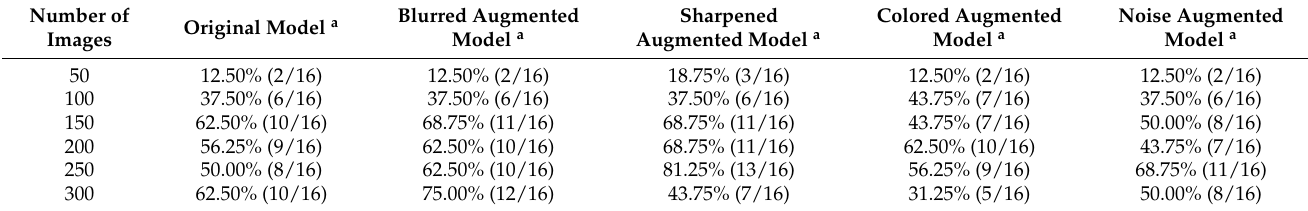
Table 2. The panoramic detection of each model.